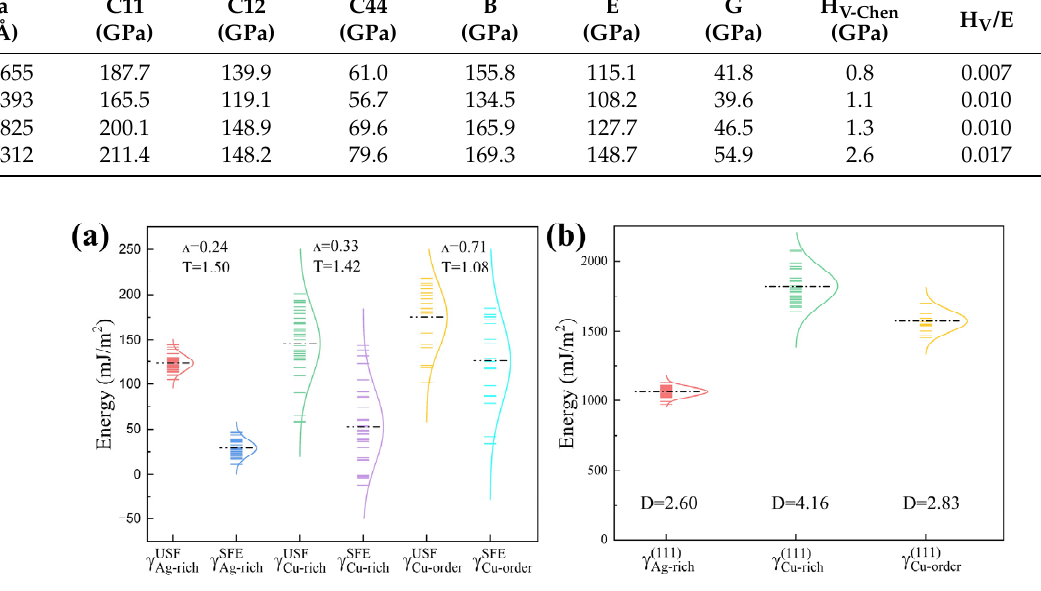
Figure 8. Prediction of plasticity and deformation mechanisms in the different phases. ( a ) The unstable ( γ USF ) and stable ( γ SFE ) stacking fault energies with the characteristic ratio Λ and the twinnability measure T . ( b ) The surface energies with the ductility parameter D